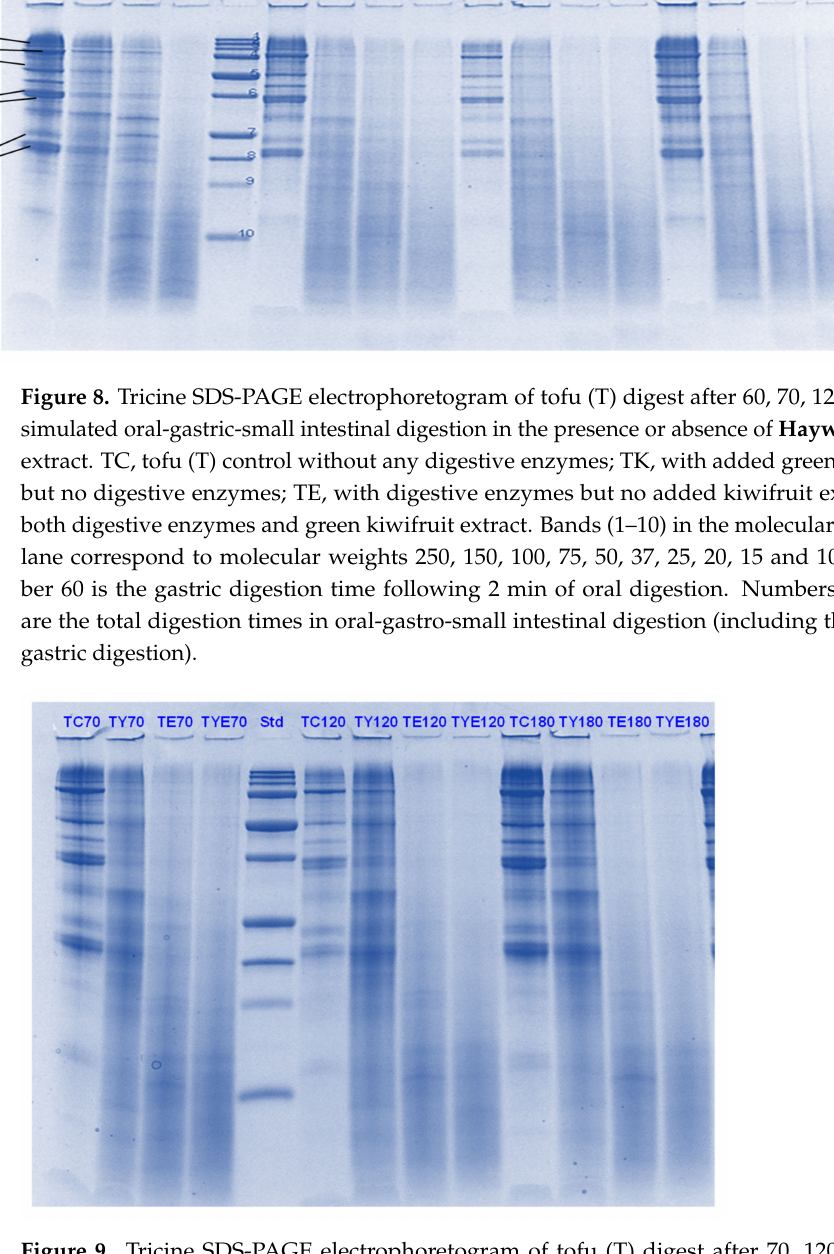
Figure 9. Tricine SDS-PAGE electrophoretogram of tofu (T) digest after 70, 120 and 180 min of simulated oral-gastric-small intestinal digestion in the presence or absence of SunGold (Y) kiwifruit extract. TC, tofu (T) control without any digestive enzymes; TY, with added gold kiwifruit extract but no digestive enzymes; TE, with digestive enzymes but no added kiwifruit extract; TYE, with both digestive enzymes and gold kiwifruit extract. Bands (1–10) in the molecular weight standard lane correspond to molecular weights 250, 150, 100, 75, 50, 37, 25, 20, 15 and 10 kDa. Numbers 70, 120 and 180 are the total digestion times in oral-gastro-small intestinal digestion (including the first 60 min of gastric